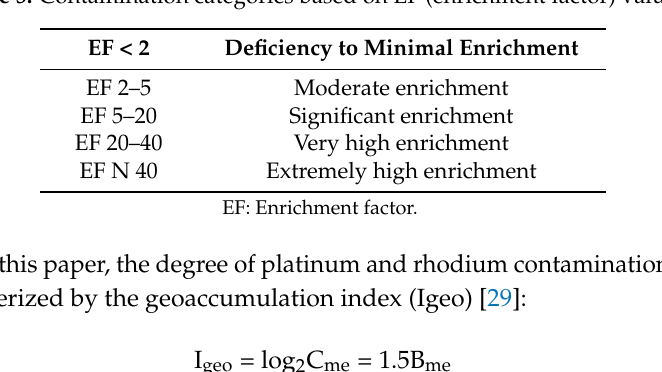
Table 5. Contamination categories based on EF (enrichment factor) values.